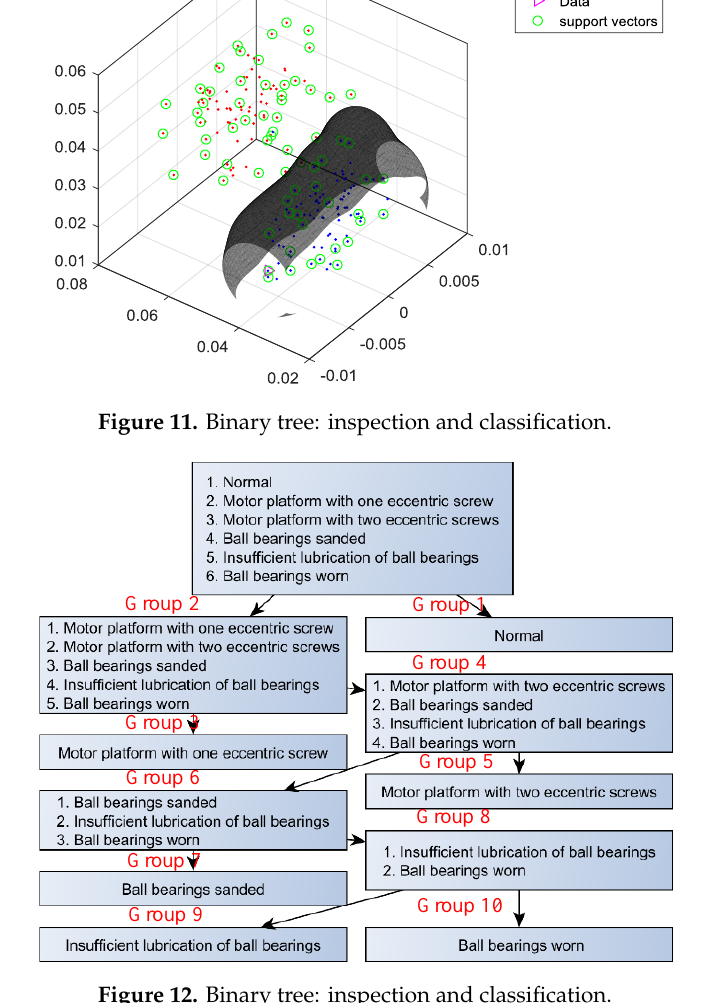
Figure 12. Binary tree: inspection and classification. Table 4. Accuracy of multiple SVM classification by six malfunction